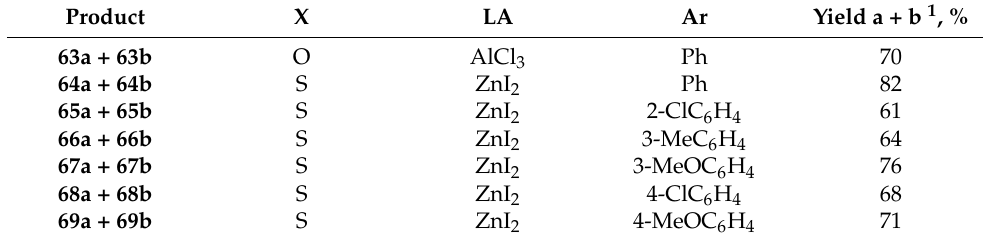
Table 4. Diels–Alder reactions of methylideneimidazolones with isoprene.